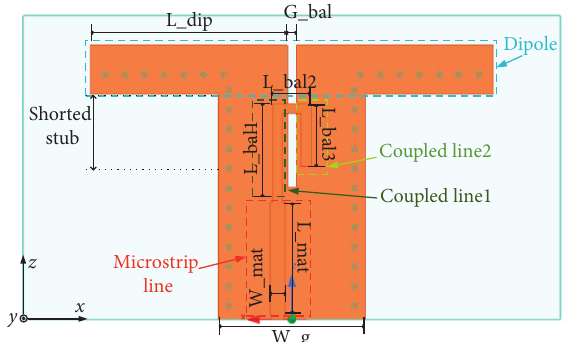
Figure 1: Structure of the dipole unit cell.